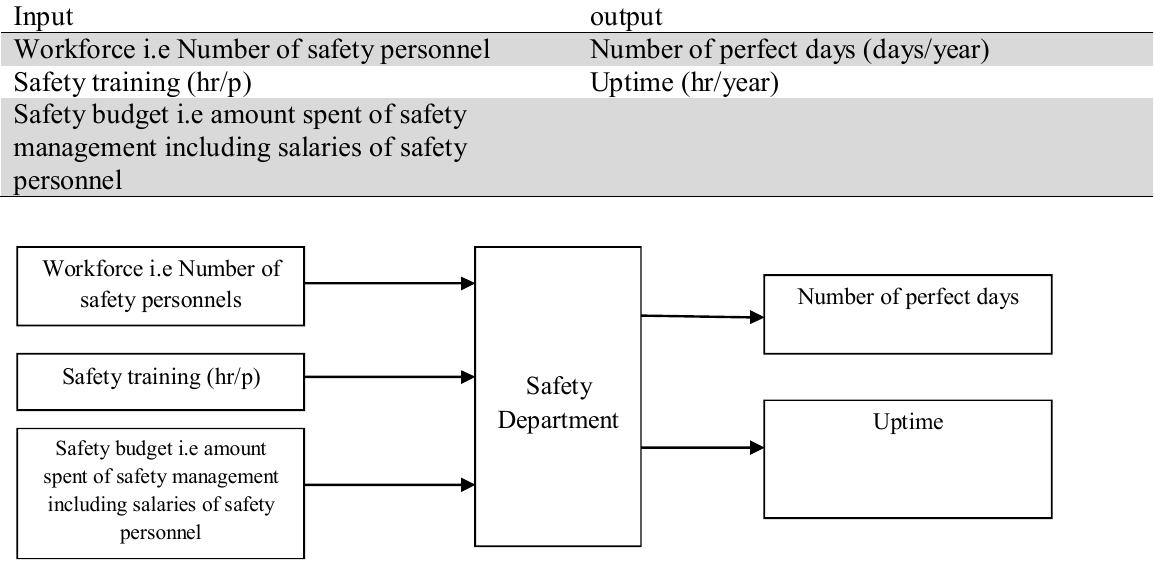
Fig. 2. Efficiency evaluation model used for this